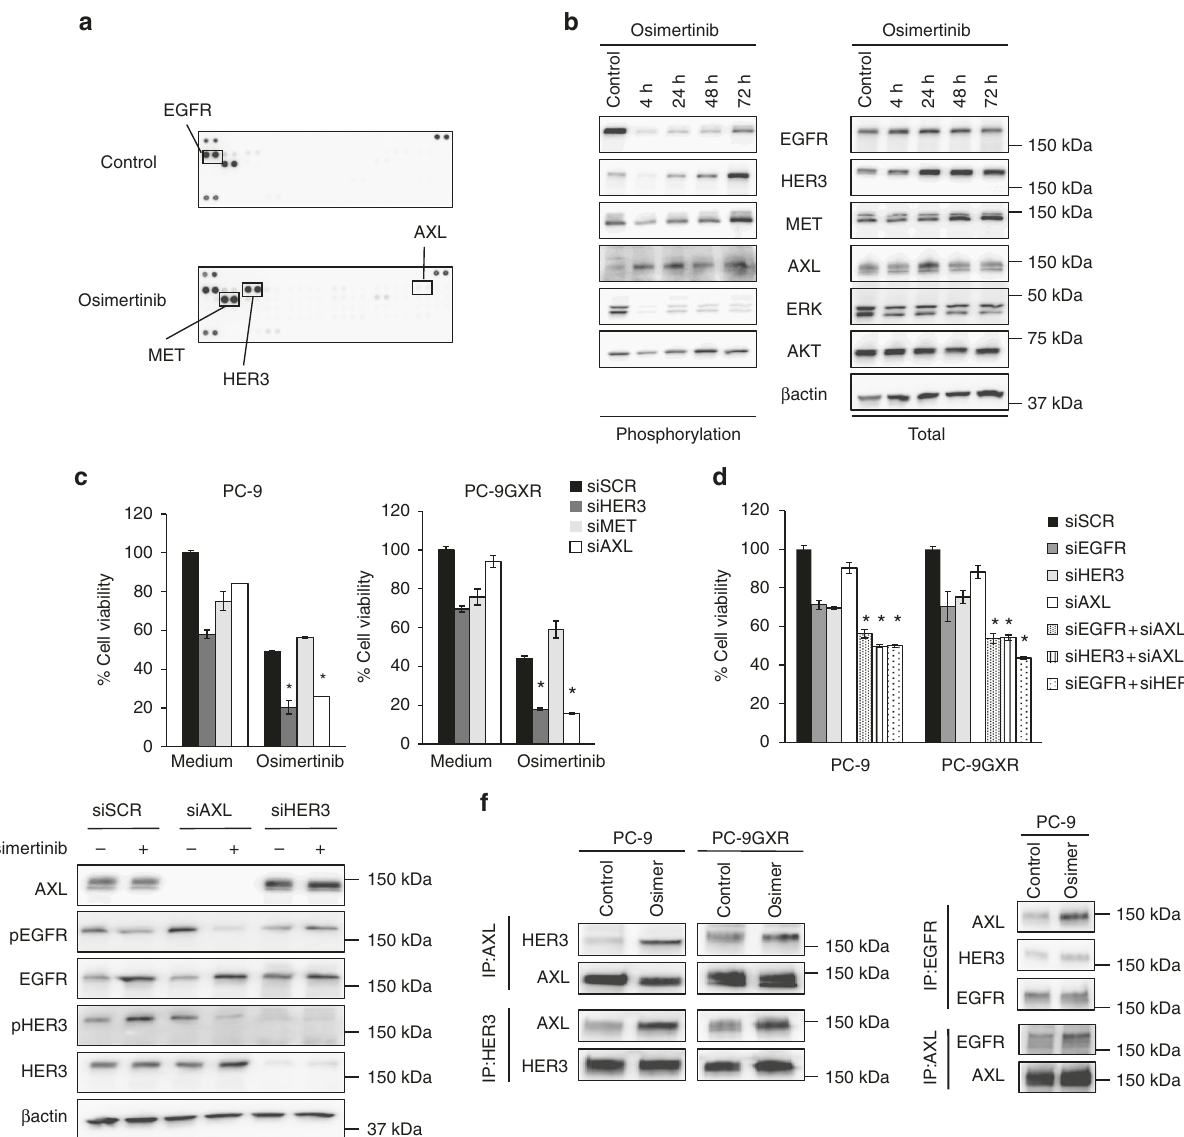
Fig. 1 Osimertinib activated AXL in EGFR -mutated NSCLC cells in vitro. a Human tyrosine kinase phosphorylation array analysis of PC-9 cells in the presence or absence of osimertinib (100 nmol/L) for 72 h. b PC-9 cells were treated with osimertinib (100 nmol/L), lysed, and the indicated proteins detected by western blotting. c Nonspeci fi c siRNA control, speci fi c siRNA for AXL , HER3 or MET introduced into the indicated cells. After 24 h, the cells were incubated with or without osimertinib (100 nmol/L) for 72 h and cell viability was determined using MTT assays. * P < 0.05 for comparisons of osimertinib-treated cells with parental cells treated with nonspeci fi c control siRNA. Comparisons by paired Student ’ s t tests. d PC-9 cells were treated for 72 h with the indicated siRNAs, or combinations of the indicated siRNAs and cell viability was determined using MTT assays. * P < 0.05 compared with the respective parental cells. Comparisons by paired Student ’ s t tests. e The indicated siRNAs were introduced into PC-9 cells. After 24 h, the cells were incubated with or without osimertinib (100 nmol/L) for 72 h and lysed, and the indicated proteins detected by western blotting. f Cell lines were treated with or without osimertinib (100 nmol/L) for 72 h. The cells were lysed and the indicated proteins were detected by western blotting